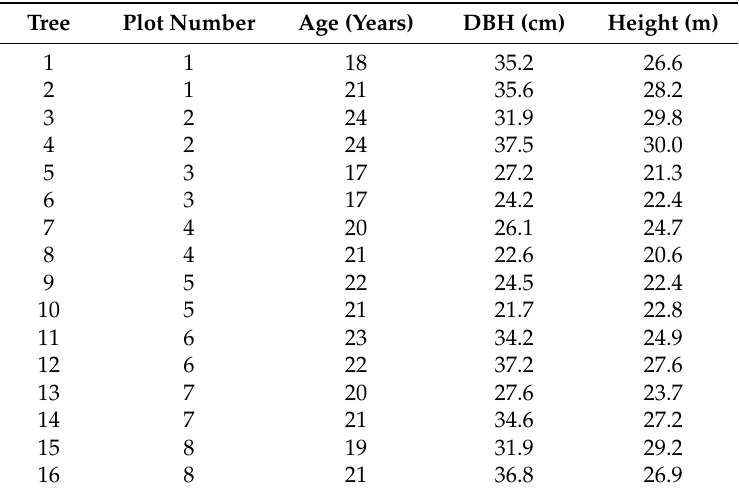
Table 5. Summary of stem analysis data by tree.